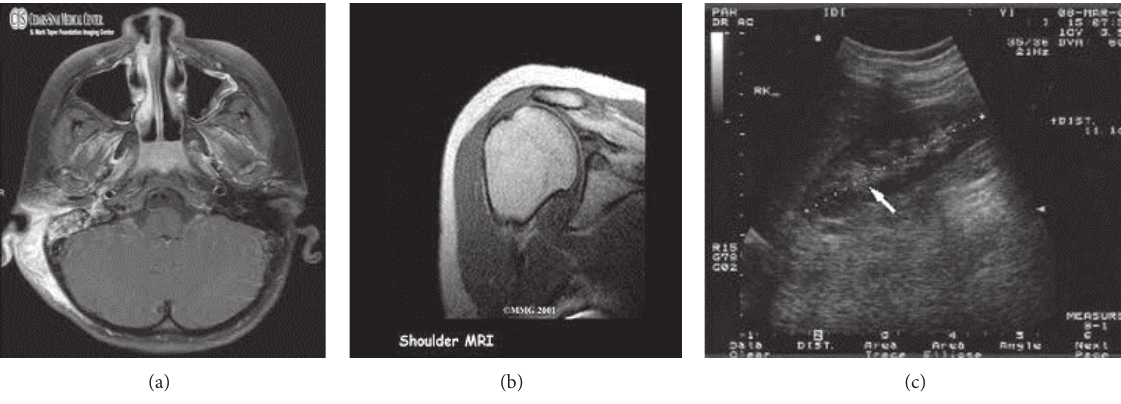
Figure 5: Recovered medical images (from left to right: CT scan, MRI scan, and